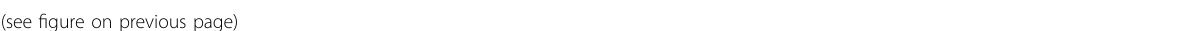
Fig. 4 IL-26 activates bypass pathway of EGFR-TKI via its EphA3 receptor in human TNBC cells. A HCC70 cells were stained with each Ab. Data are shown as histogram of IL-20RA, IL-10RB, and EphA3, and the gray area in each histogram shows isotype control data. B HCC70 cells were treated with Alexa Fluor 488-labeled recombinant human IL-26 (rhIL-26-Alexa488 (green)) (30 ng/ml) in the presence of anti-IL-26 mAb (clone 31-4 or 69-10), recombinant human EphA3-Ig (rhEphA3) or control IgG (50 µg/ml, each) for 1 h, followed by immunostaining with anti-human EphA3 pAb (red) and DAPI (blue). Original magni fi cation, ×200. Scale bar, 20 μ m. C HCC70 cells were treated with recombinant human IL-26 (30 ng/ml) for 1 h, followed by immunostaining and in situ PLA detection of IL-26-EphA3 interaction (green). Cell nuclei are counterstained with DAPI (blue). Original magni fi cation, ×200. Scale bar, 20 μ m. D HCC70 cells were treated with IL-26 (30 ng/ml) and ge fi tinib (40 µM) in the presence of the indicated Abs or rhEphA3-Ig (50 µg/ml, each) for 48 h. Data are shown as mean ± S.D. of triplicate samples. * p < 0.01. E , F HCC70 cells were transfected with siRNA and stimulated with IL-26 (30 ng/ml) in the presence or absence of ge fi tinib (40 µM) for 48 h. The expression level of EphA3 was con fi rmed by western blotting ( F ). Data are shown as mean ± S.D. of triplicate samples. * p < 0.01. G MDA-MB231 cells (EphA3-negative) were transfected with EphA3 plasmid and stimulated with IL-26 (30 ng/ml) in the presence or absence of ge fi tinib (40 µM) for 48 h. The expression level of cell surface EphA3 was con fi rmed by Flow cytometry (Supplementary Fig. S8). Data are shown as mean ± S.D. of triplicate samples. * p < 0.01. H HCC70 cells were treated with IL-26 (30 ng/ ml) or Ephrin A5 (200ng/ml) in the presence of ge fi tinib (40 µM) for the indicated periods, and then submitted to western blot analysis using anti- phosphorylated EphA3, AKT, and JNK antibodies, and reblotting with anti-pan EphA3, AKT, and JNK antibodies. I . HCC70 cells were treated with IL-26 (30 ng/ml) and ge fi tinib (40 µM) in the presence of anti-EphA3 pAb or isotype control IgG (50 µg/ml, each) for 15 min, and then submitted to Western blot analysis as described in H . A – I Data shown are representative of three independent experiments with similar results. D , E , G Cell proliferation was assessed by MTT assay. The dashed line is the standard value of ge fi tinib plus vehicle. H , I Band intensity of phospho-proteins was normalized to the appropriate pan proteins, and relative intensity compared with unstimulated cells is shown as mean ± SEM from three independent experiments. * p <